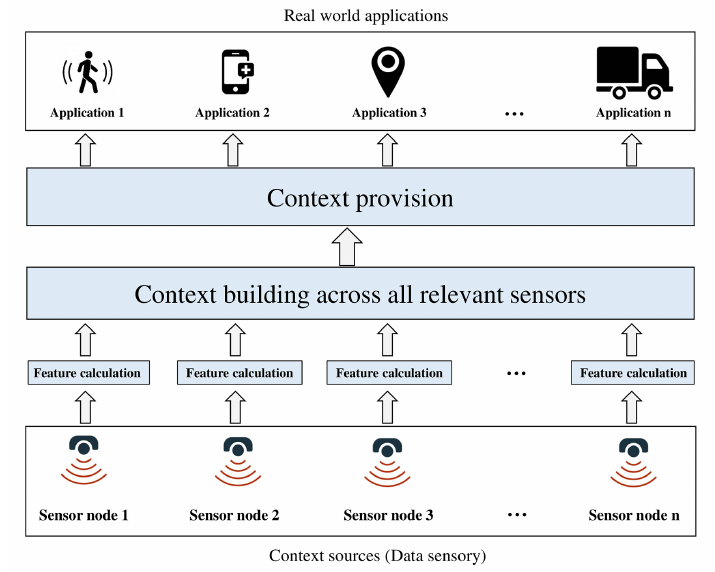
Figure 2. Context-aware framework